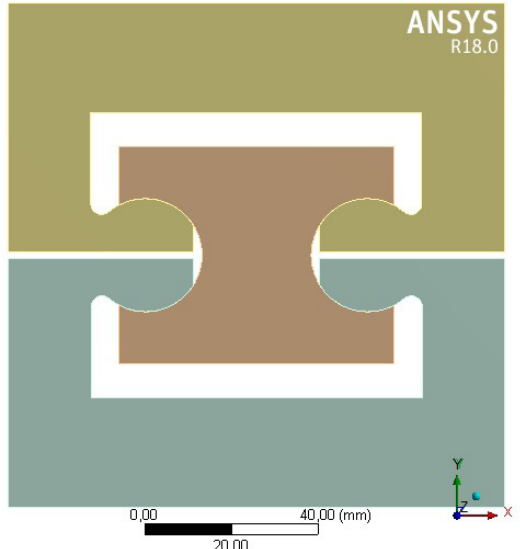
Figure 5. Apparatus used to the numerical analysis.